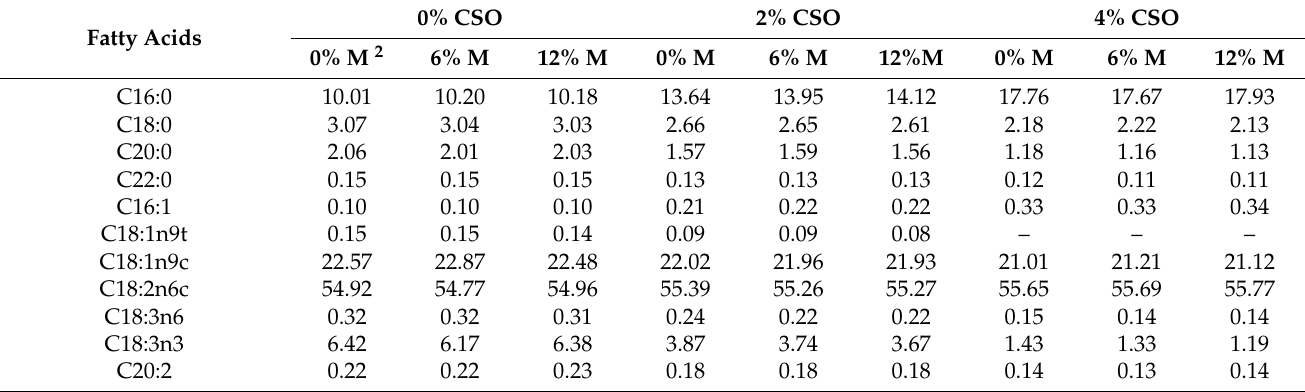
Table 3. Fatty acid composition of experimental diets (g/100g of total fatty